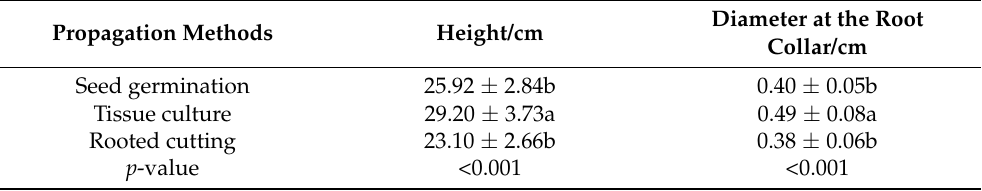
Table 1. Height and root collar diameter before transplanting of Chinese fir trees.